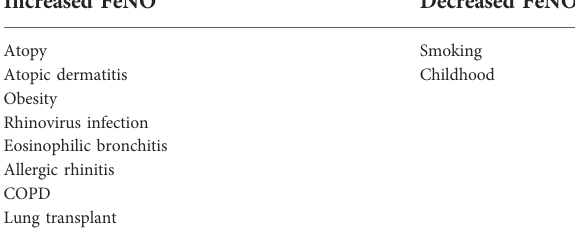
TABLE 2 Factors affecting FeNO